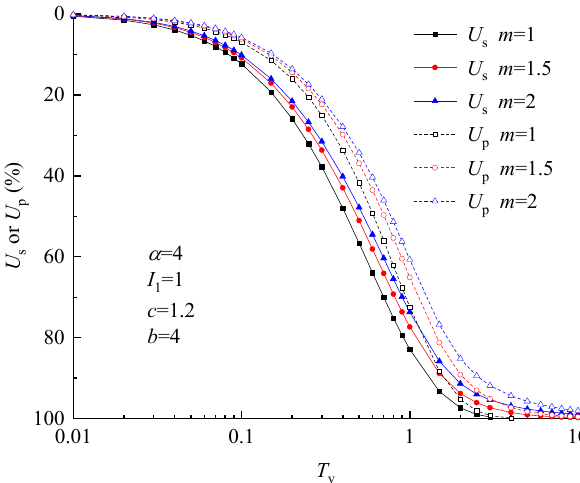
Figure 5. Influence of the m value on ACDs.